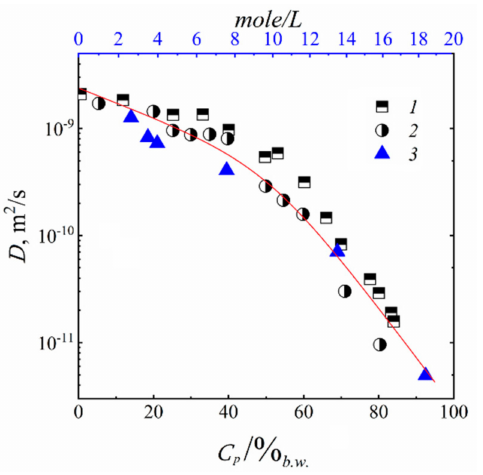
Figure 52. Water self-diffusion coefficients dependences on concentration (water content) in (1) bovine serum albumin, (2) gelatin, and (3) perfluorinated MS-4SC membrane in acidic form (adapted from